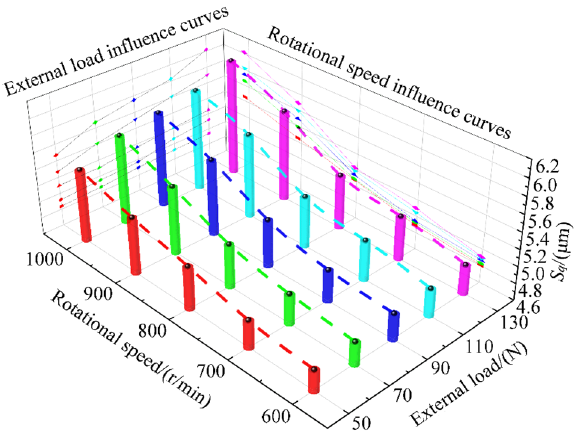
Figure 17. Effect of friction parameters on the root-mean-square deviation. (red is the value of S q at different rotational speeds at 50N, green is the value of S q at different rotational speeds at 70N, blue is the value of S q at different rotational speeds at 90N, light blue is the value of S q at different rotational speeds at110N, and pink is the value of S q at different rotational speeds at 130N).